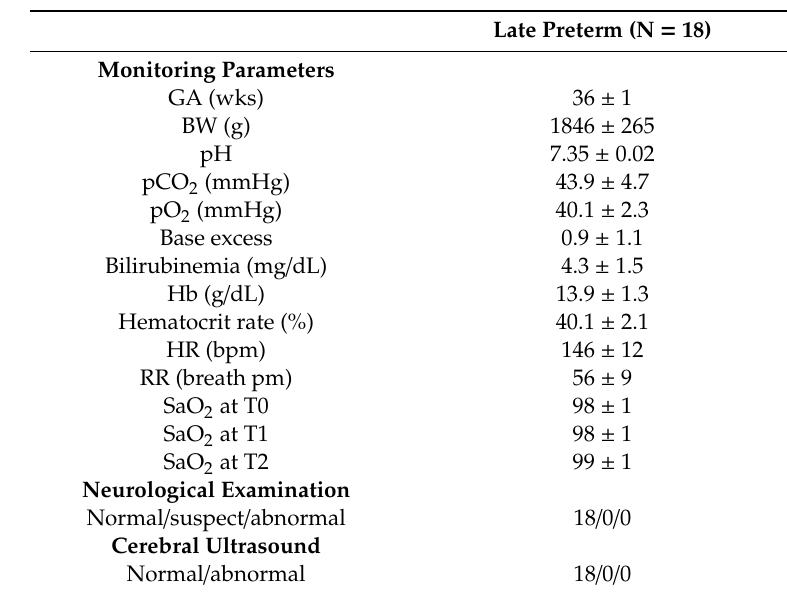
Table 2. Standard laboratory and monitoring parameters recorded before osteopathic manipulation treatment and near infrared spectroscopy performance in late preterm infants. Data are given as mean ±